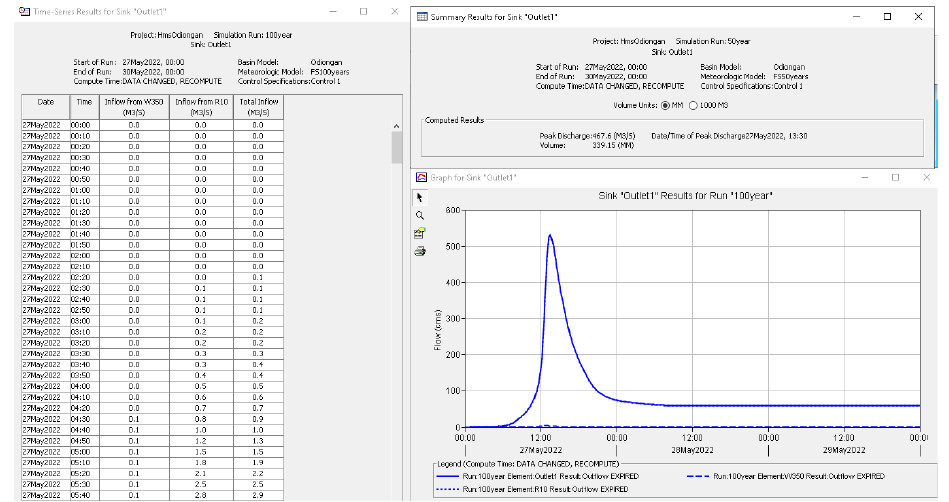
Figure 5. Simulation of total inflow results in 100 ‐ year using HEC ‐ HMS.